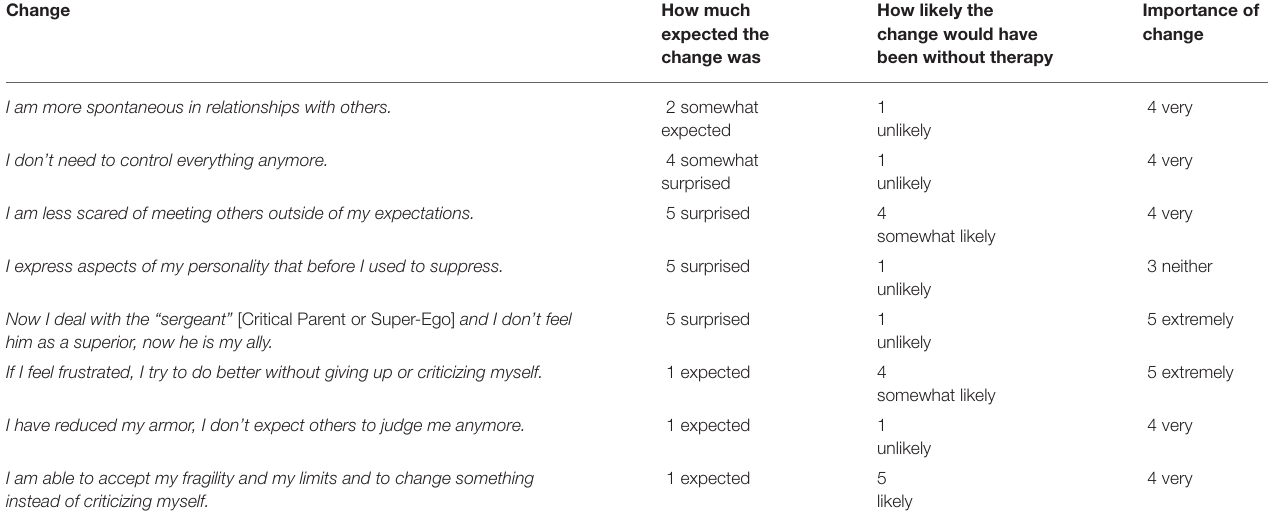
TABLE 3 | Summary change interview of Fabio. Change How much